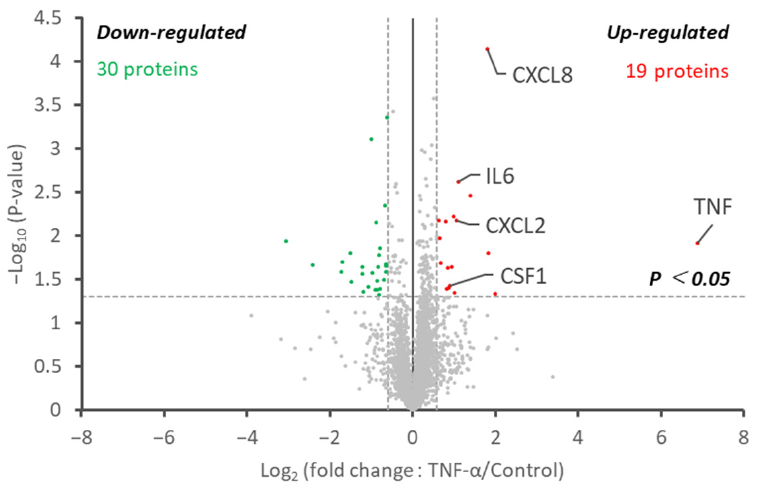
Figure 5. In-depth proteome analysis of TNF-stimulated and non-stimulated HeLa cells. The volcano plot represents the change in protein abundance upon TNF stimulation. Proteins with decreased and increased abundances are illustrated as green and red dots,